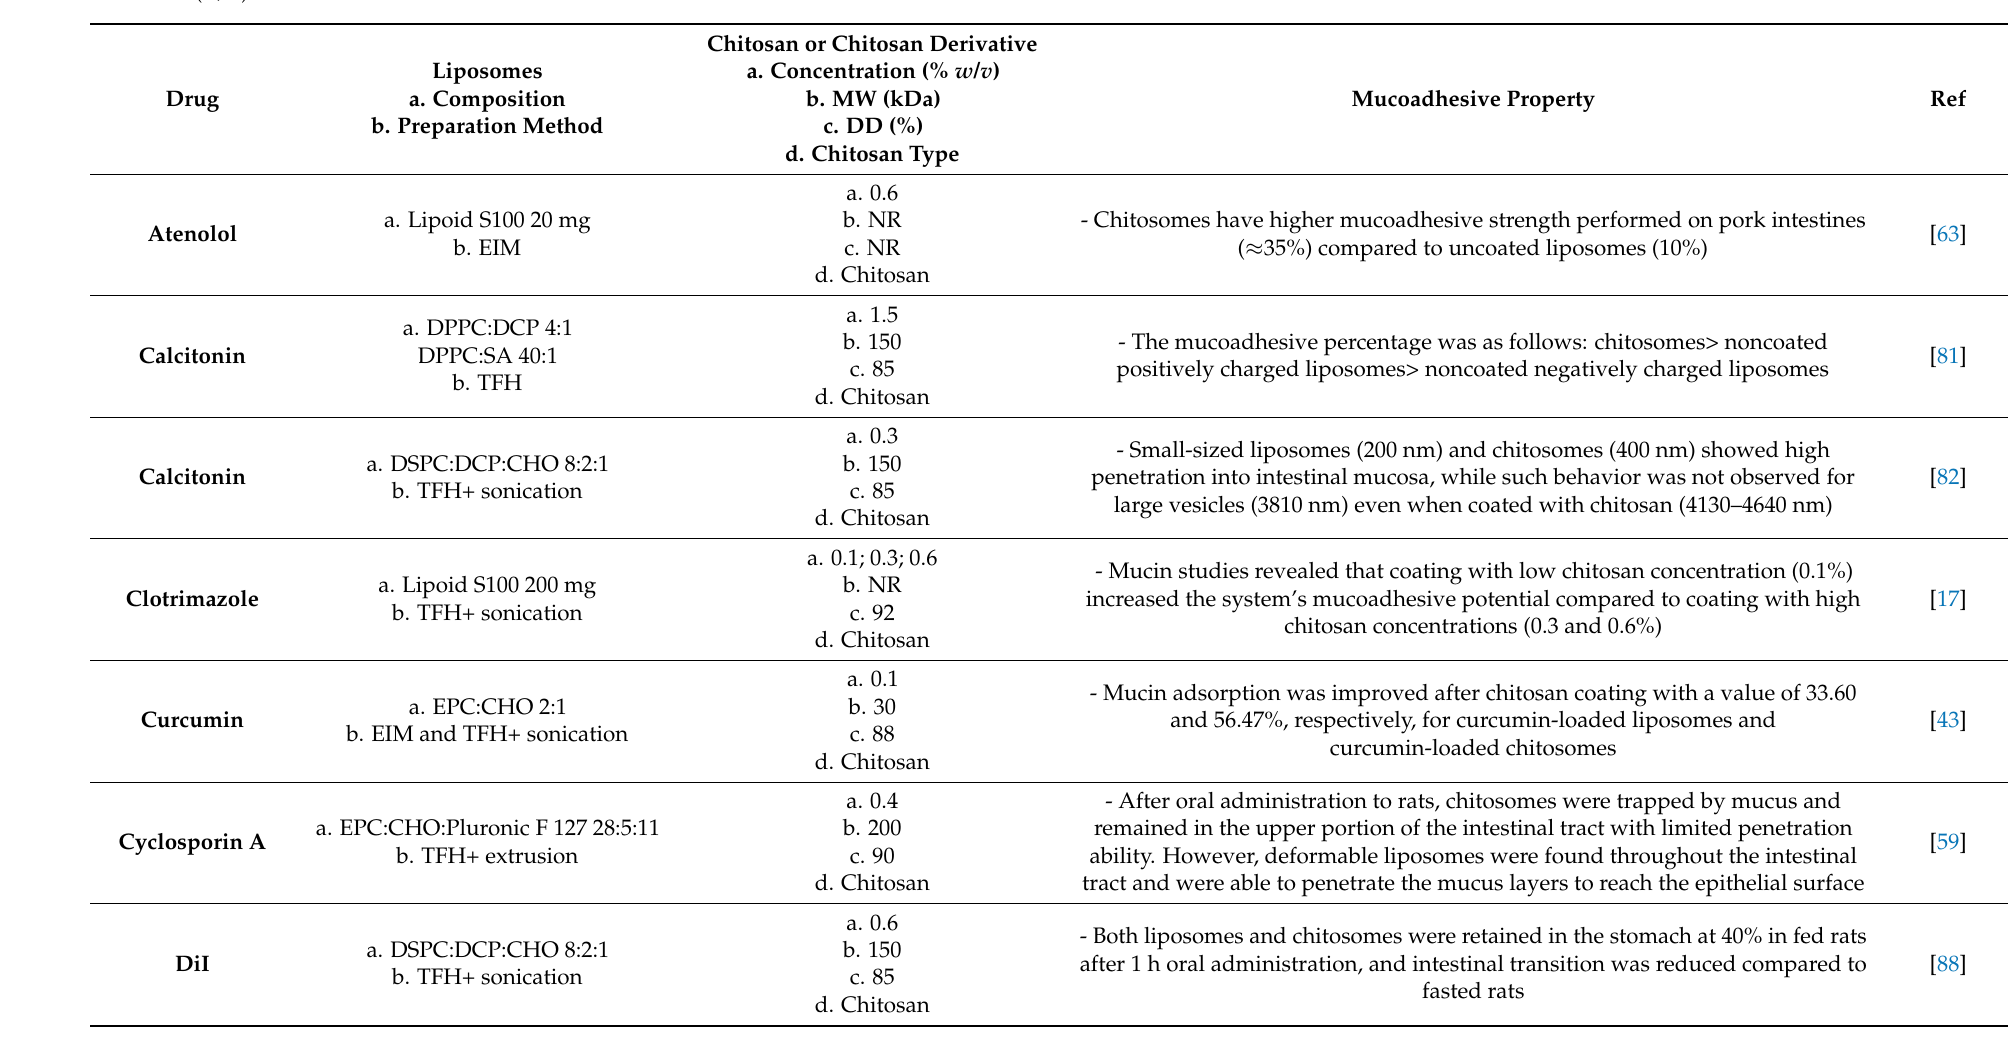
Table 9. Drug mucoadhesive property: conventional liposomes and chitosomes. The liposomal composition is indicated in the table in molar ratio except when * exists, indicating a weight ratio ( w/w